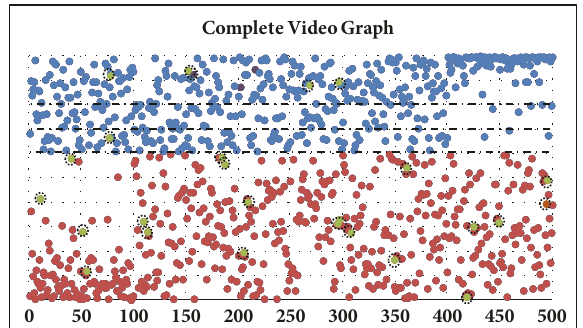
Figure 16: Result graph of application of proposed ECD system on complete (explicit/nonexplicit) video